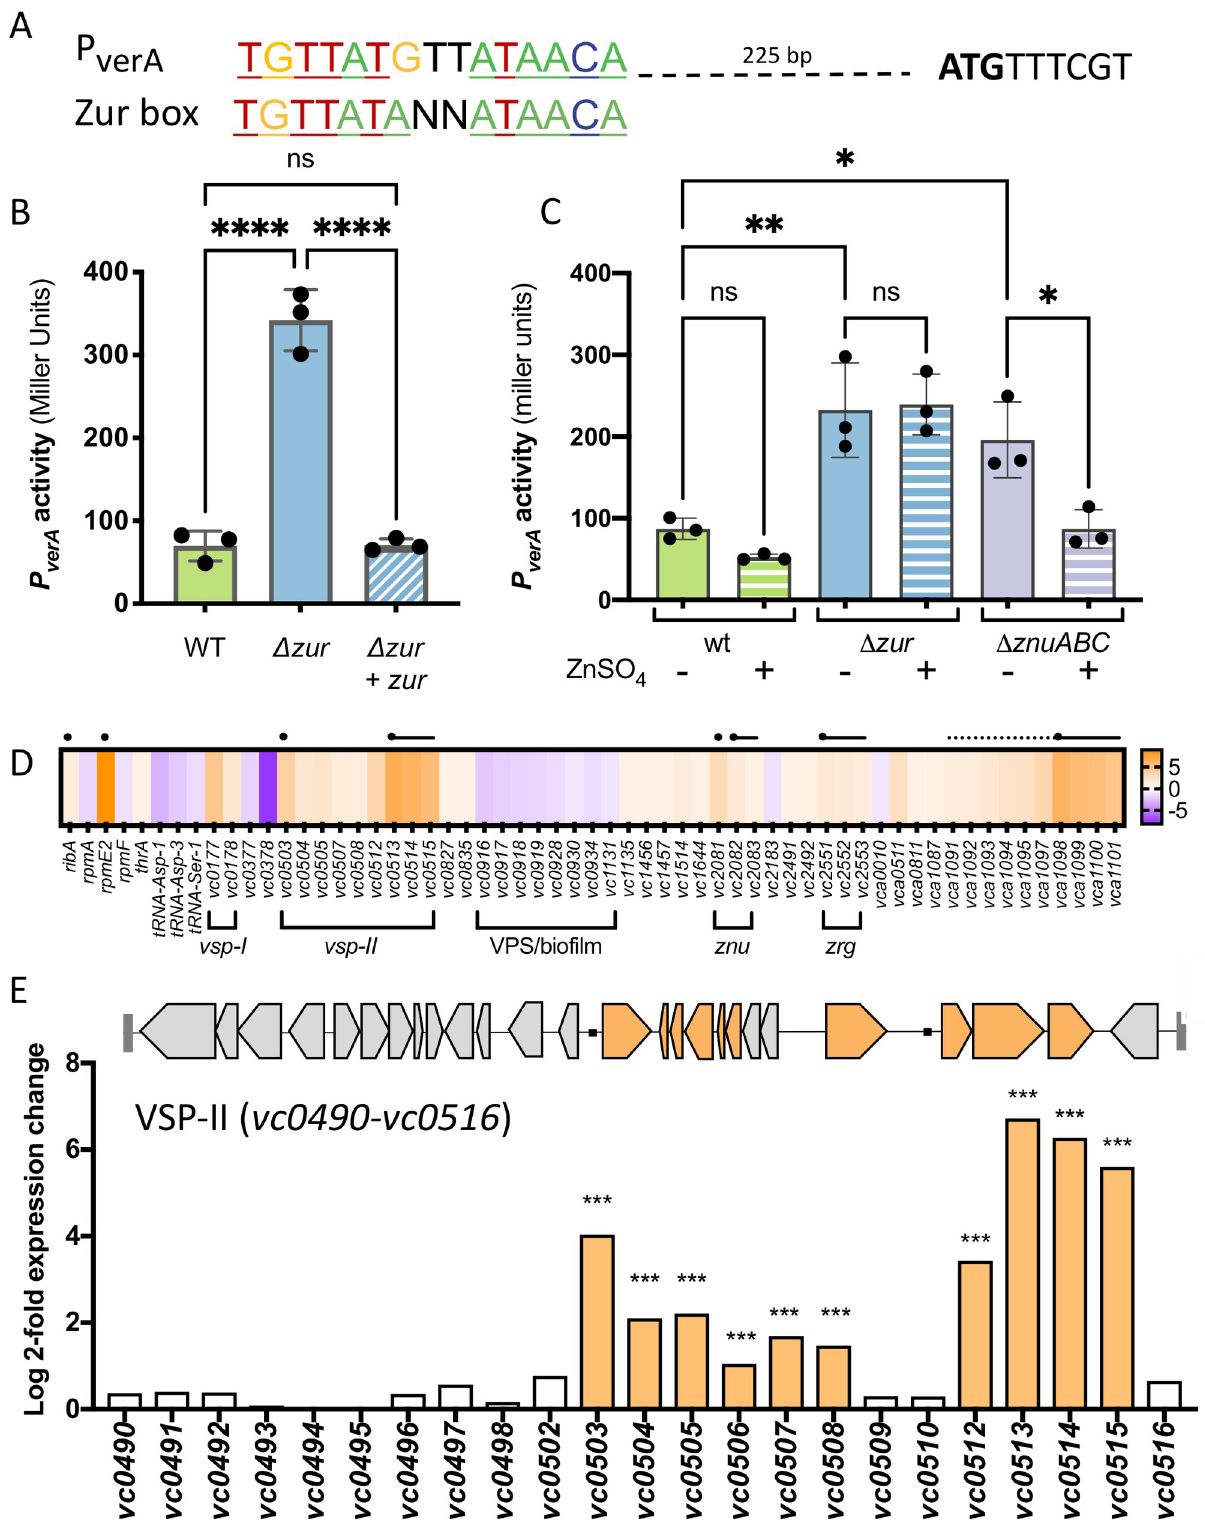
Fig 3. Several VPS-II genes are upregulated in a Δ zur mutant. (A) A predicted Zur-binding site (TGTTATGTTATAACA) located approximately 200 bp upstream of the verA open reading frame was aligned with the Vibrionacae Zur binding consensus sequence [35]. The predicted start codon